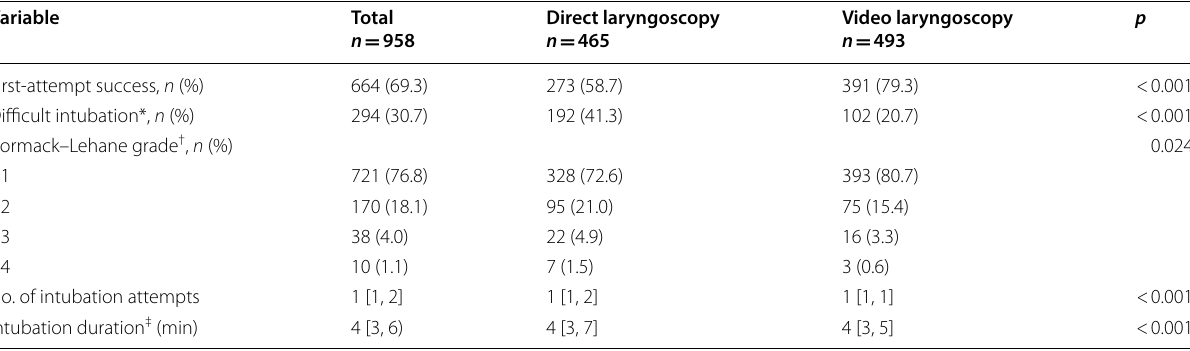
Values are expressed as median (interquartile range) or n (%)